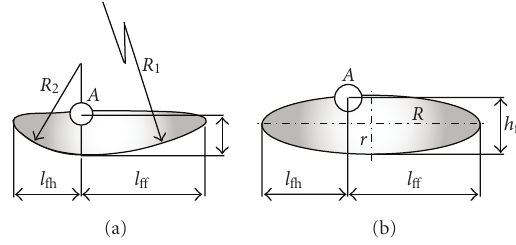
Figure 7: Foot design: (a) two cylindrical surfaces with di ff erent radii, (b) ellipsoidal cylinder (ankle joint is marked by A ).